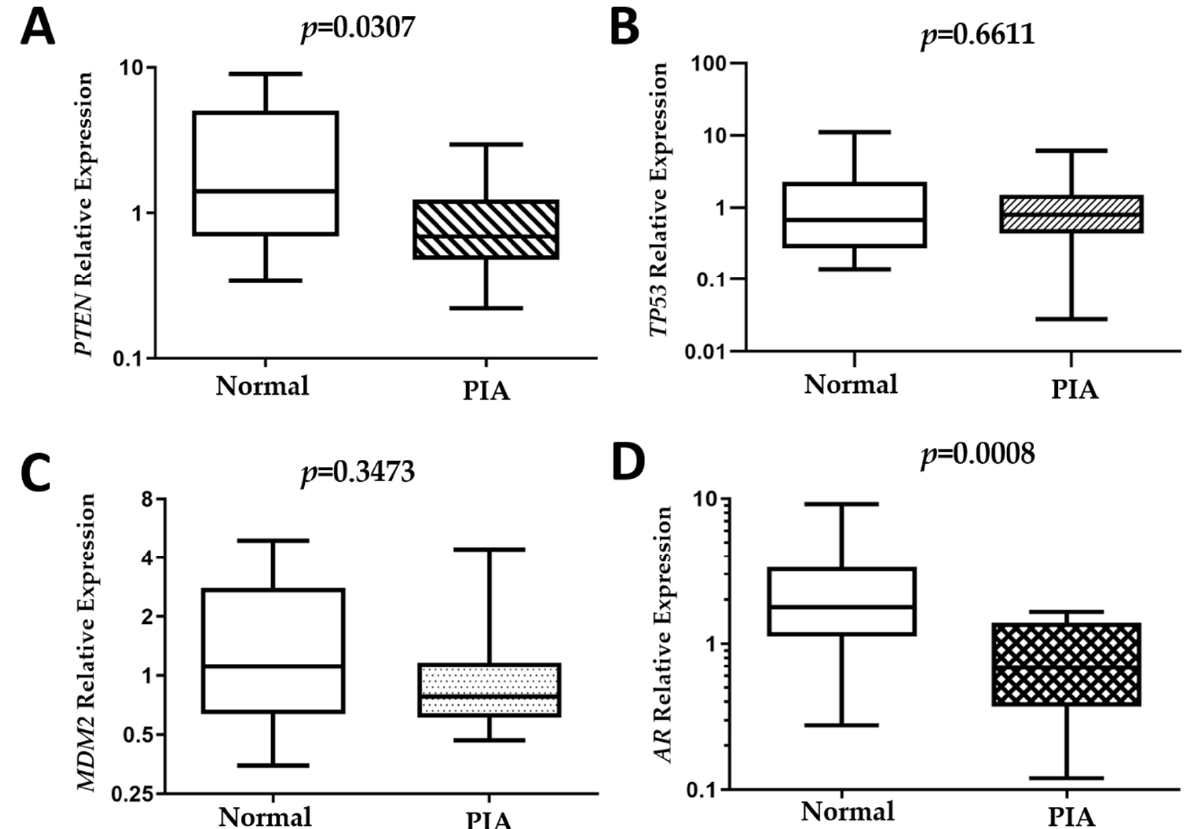
Figure 5. Evaluation of PTEN, TP53, MDM2 and AR gene expression in normal compared to proliferative inflammatory atrophy (PIA) samples. ( A ) Decreased PTEN expression was observed in PIA samples compared to normal samples ( A ). TP53 ( B ) and MDM2 ( C ) transcripts showed no statistically significant differences. AR expression decreased in PIA samples compared to normal samples ( D ).